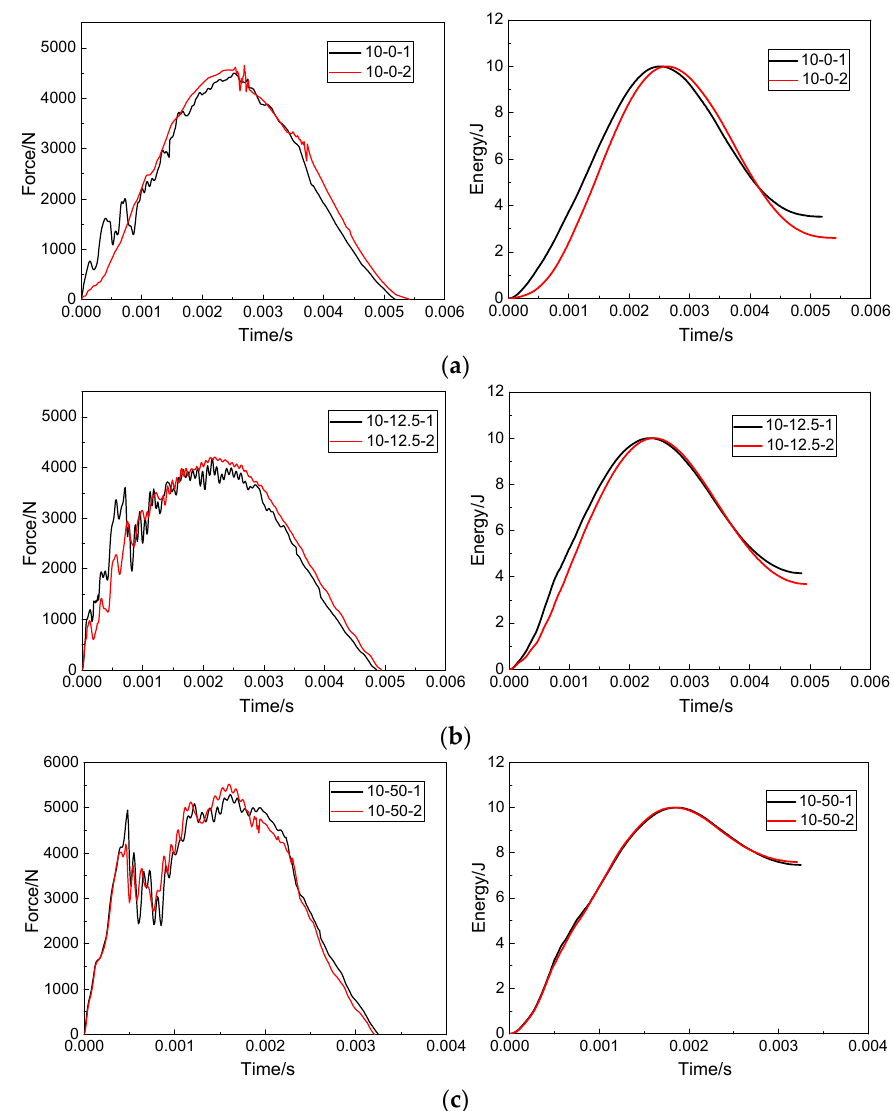
Figure 7. Force–time curves and impact energy curves of patch-repaired specimens under double impacts at impact distances of ( a ) 0 mm, ( b ) 12.5 mm, ( c ) 50